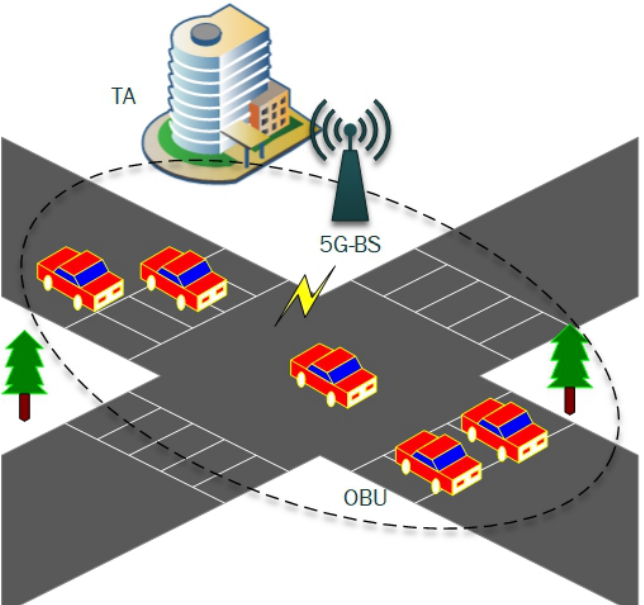
Figure 1. Architectural design of our work for 5G-enabled vehicular